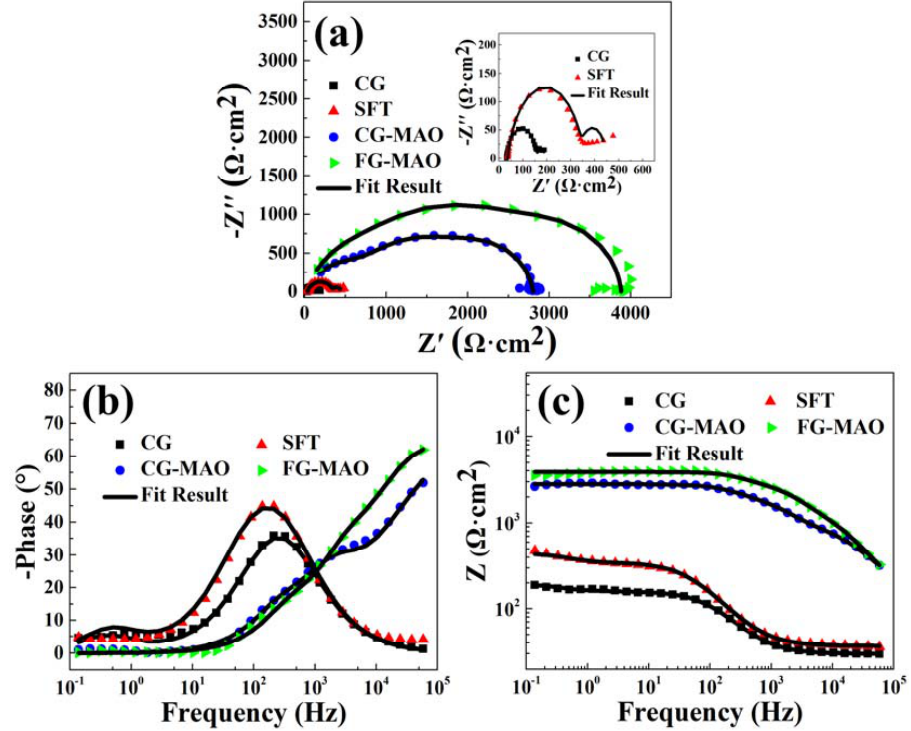
Figure 8. The electrochemical impedance spectroscopy (EIS) of all samples in SBF: ( a ) Nyquist plot; ( b , c ) Bode plots.